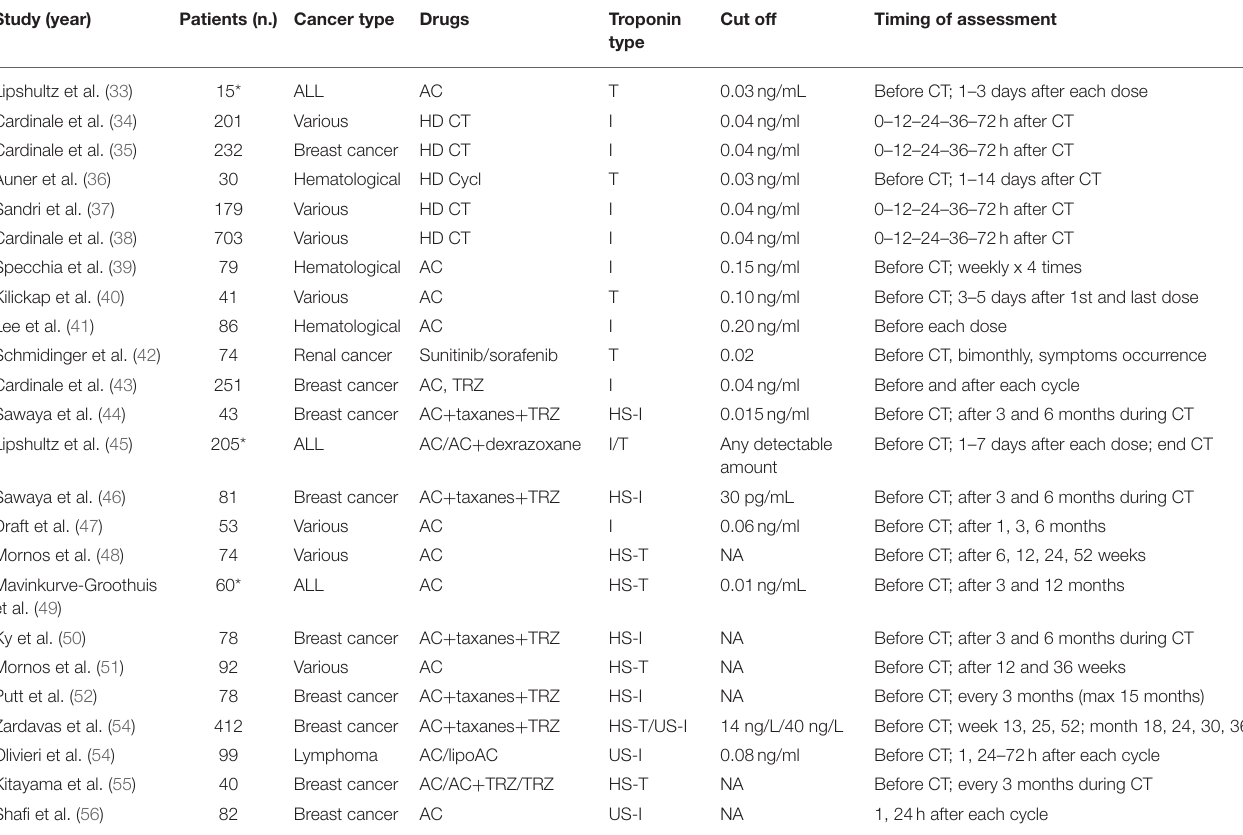
TABLE 3 | Clinical studies demonstrating Troponins as predictor of anticancer drug-induced left ventricular dysfunction (33–56). Study (year) Patients (n.) Cancer type